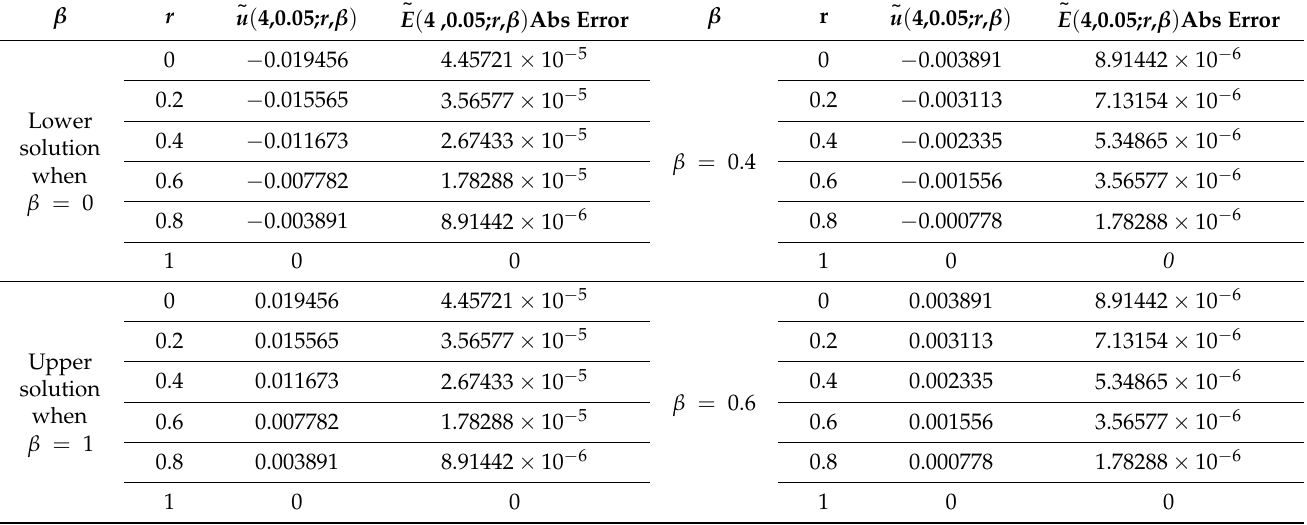
Table 1. Fuzzy numerical solution of Equation (30), by explicit finite difference scheme at t = 0.05, x = 4 and α = 0.9 for all r, β ∈ [ 0,1 ]